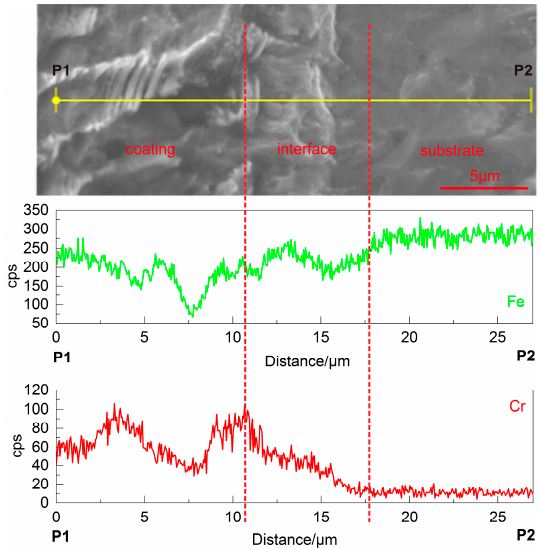
Figure 5. Results of Energy Dispersive Spectrometer (EDS) line analysis at the interface of coating and substrate.